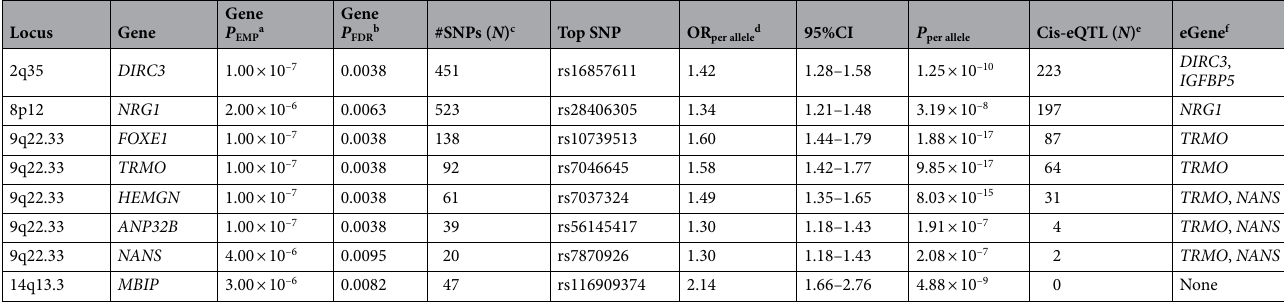
Table 2. Genes associated with DTC risk, SNPs and eQTL within or in the vicinity of these genes, and effect of eQTL on the expression of genes in cis. a Empirical p-value of the association test at the gene level. b p-value of the association test with DTC risk at the gene level, after FDR correction. c Number of analyzed SNP within the gene or at ± 50 kb from the gene boundaries. d Per allele Odds Ratio (OR) for the top SNP at the gene locus. e number of eQTL at the gene locus. f Gene whose expression is affected by the